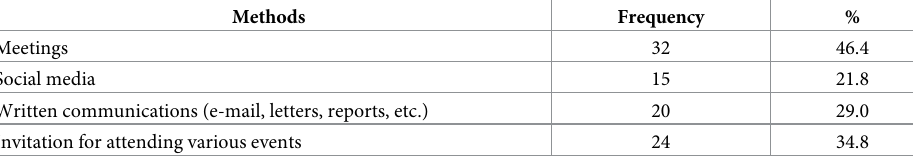
Table 9. Communication methods followed in the partnerships.